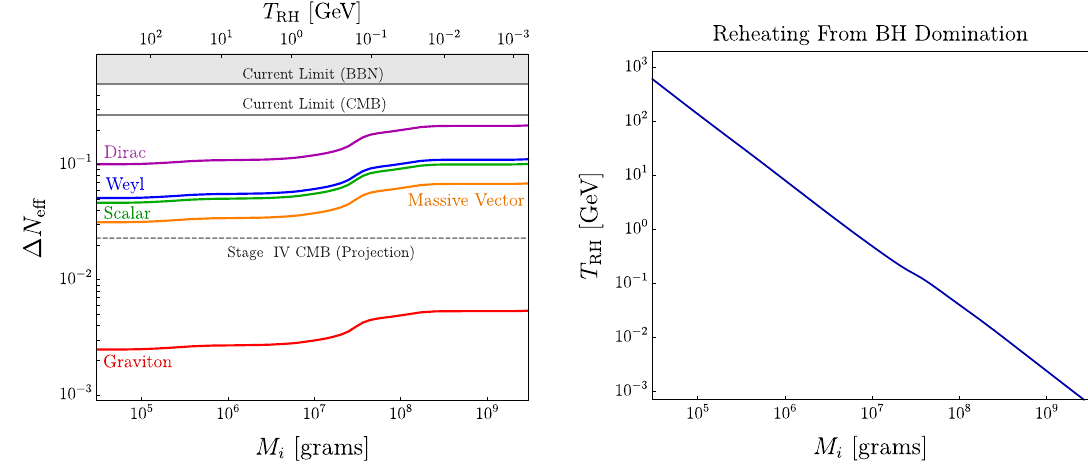
Figure 1 . In the left frame, we show the contribution to the effective number of neutrino species from Hawking evaporation in a scenario in which the early universe included a black hole domi- nated era. Results are shown for a single, light decoupled state that is either a Dirac fermion, Weyl Fermion, real scalar, massive vector, or massless spin-2 graviton, as a function of the temperature of the universe after black hole evaporation. Also shown are the current constraints [31] as well as the projected sensitivity of stage IV CMB measurements [84–86]. For ∆ N eff tween the value of the Hubble constant as determined from local measurements and as inferred from the temperature anisotropies in the cosmic microwave background can be substantially relaxed [28– 30]. In the right frame, we show the relationship between the initial mass of the black holes and the temperature of the universe following their evaporation, assuming black hole